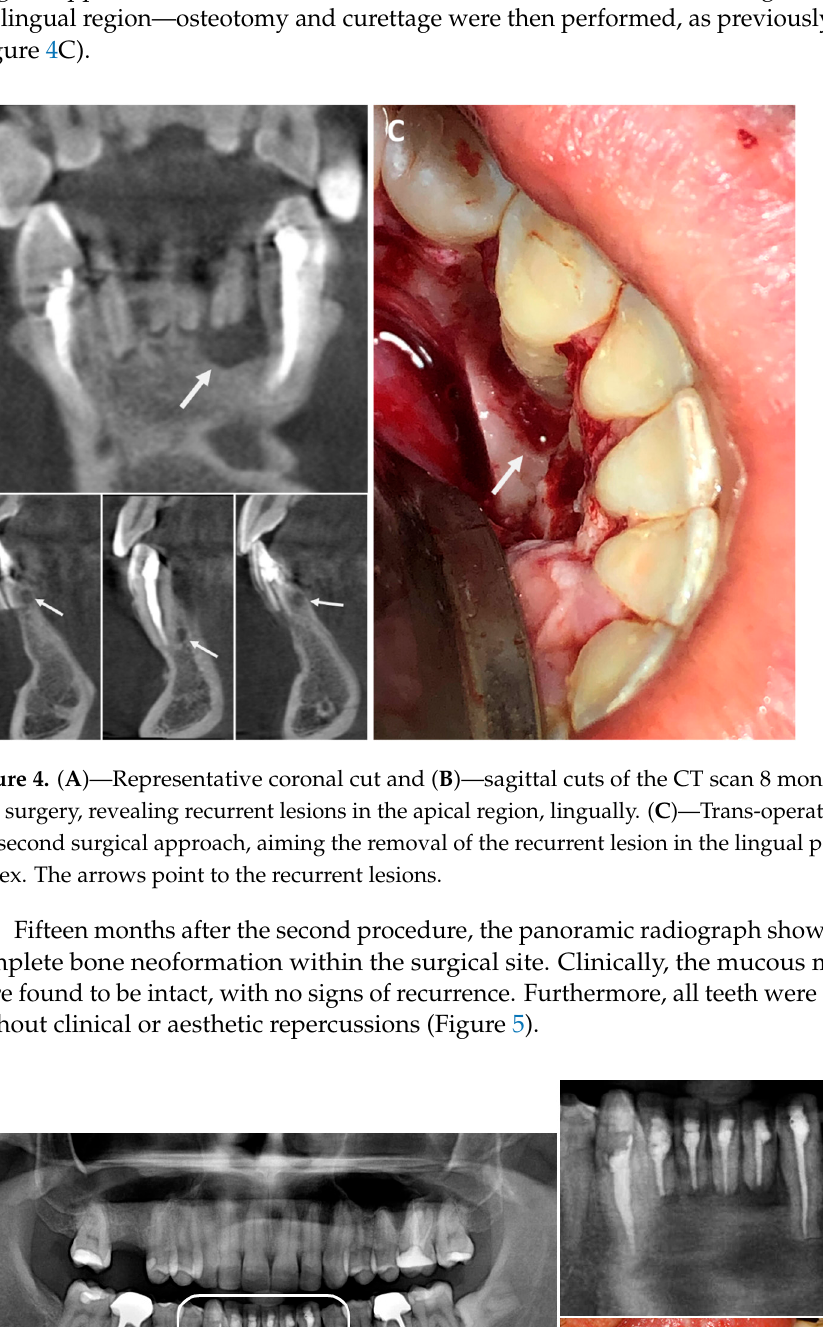
Figure 3. Trans-operative images of the surgical procedure. ( A )—First surgery—the surgical access and the ostectomy were performed via vestibular cortex. ( B )—Surgical fl ap was positioned, and sutures were performed.